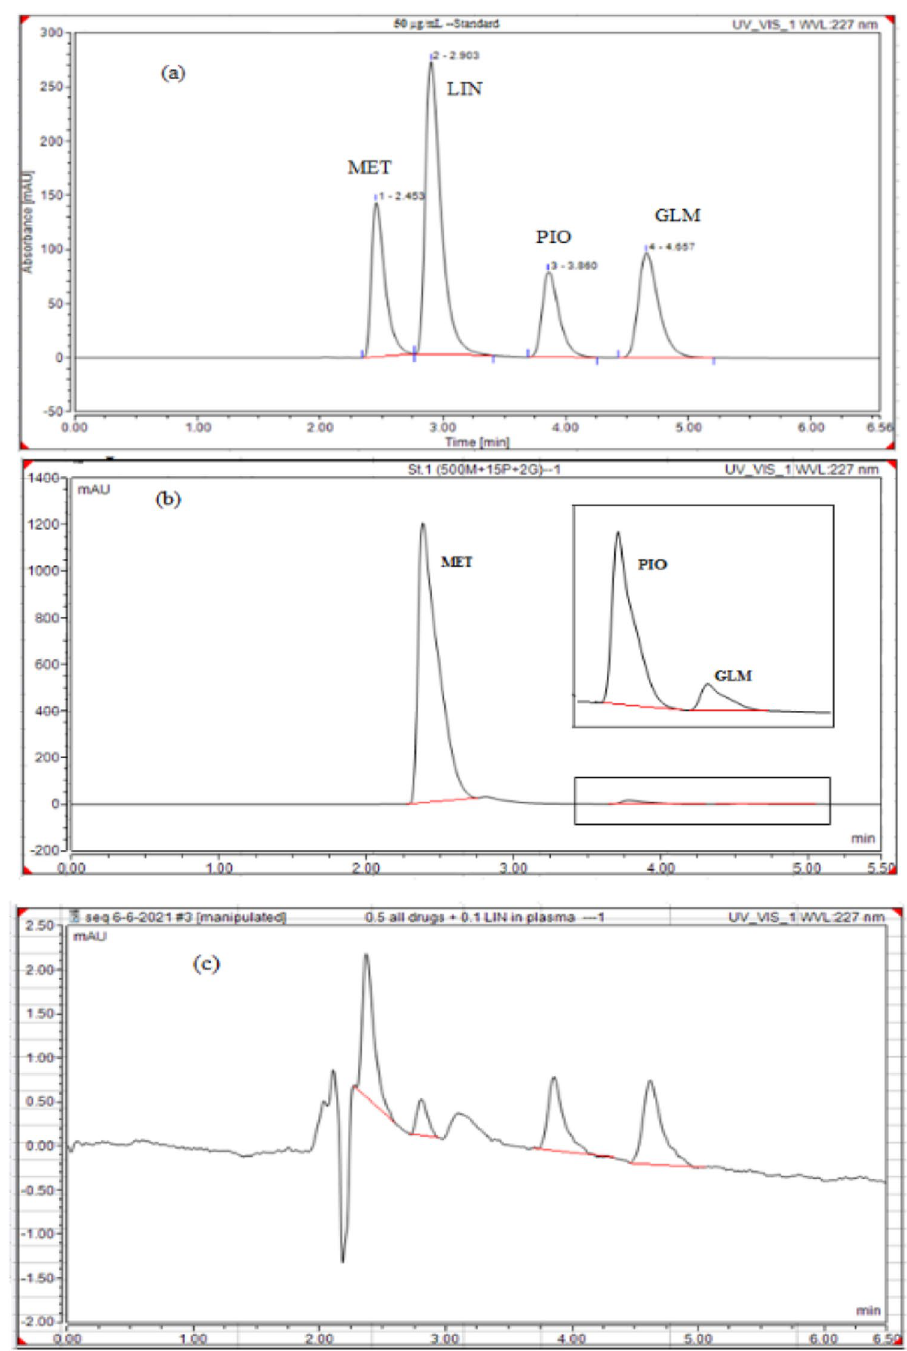
Figure 4. Chromatograms for standard pure drugs ( a ), lab-prepared mixture ( b ), and spiked plasma ( c